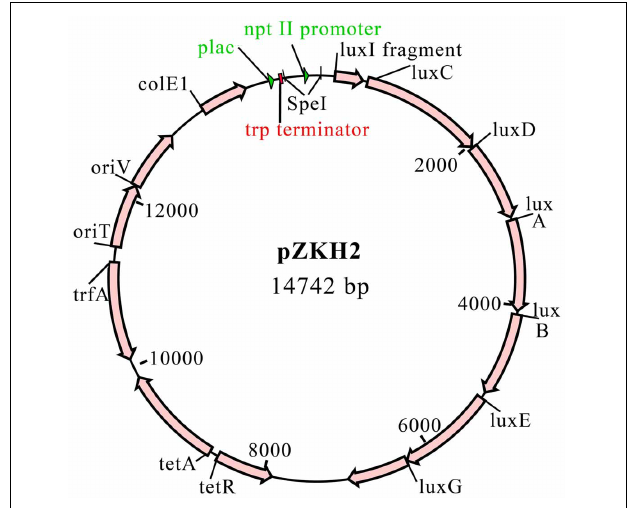
FIGURE 1 | Plasmid pZKH2 with nptII-luxCDABE